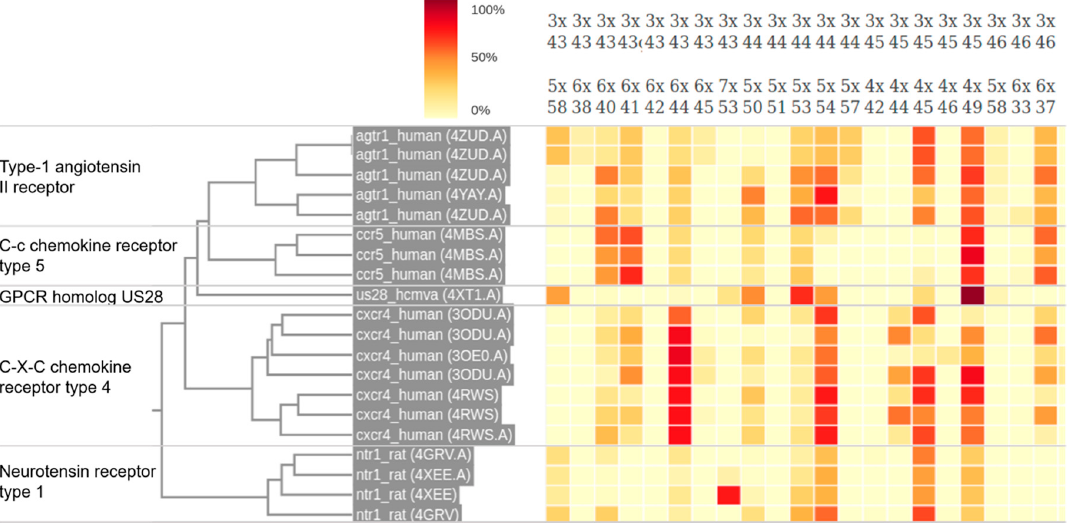
Figure 5. Pattern of total interaction frequency of several MD simulations of GPCRs, extracted from the GPCRmd Receptor Meta-analysis tool (https://submission.gpcrmd.org/contmaps/) of the GPCRmd server [53]. Columns represent interacting residue pairs according to Ballesteros-Weinstein residue numbering [142], whereas rows represent different simulations. The color of each cell shows the frequency in which any type of non-covalent interaction occurs during the simulation. Results are clustered based on the interaction frequencies of the simulations. This clustering is able to separate simulations according to the receptor subtype, showing that different receptor subtypes present differentiated interaction patterns.